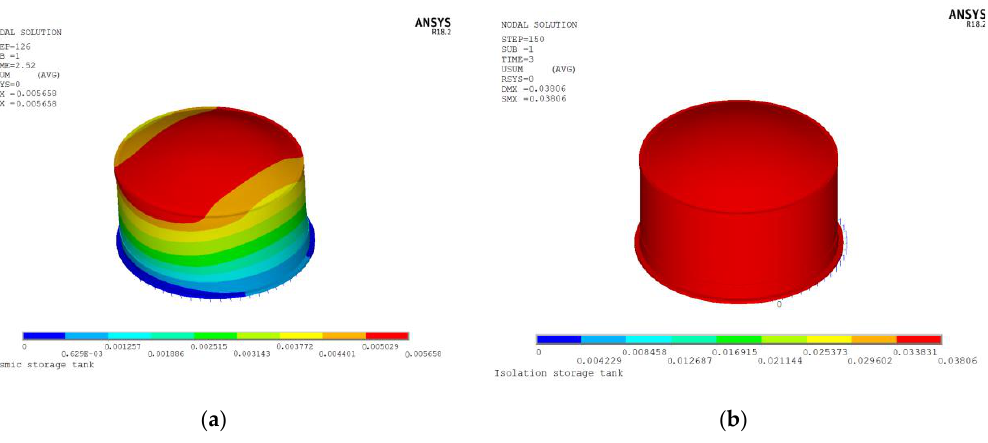
Figure 16. Displacement cloud diagram of storage tank: ( a ) seismic storage tank; ( b ) isolation storage tank.